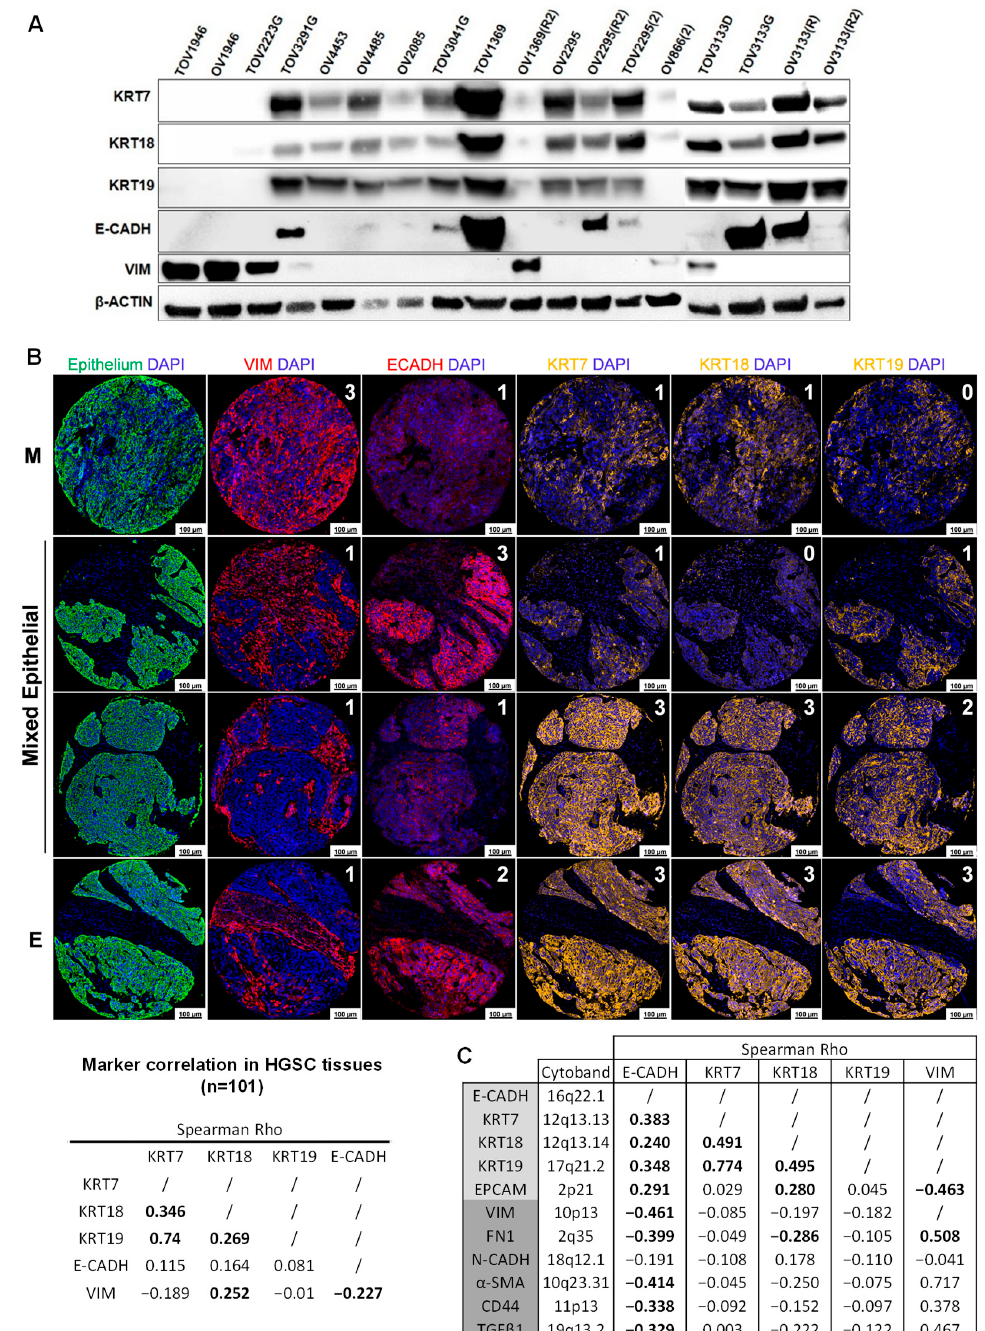
Figure 1. HGSC cell lines and tissues display a high variability in epithelial marker expression. ( A ) E-CADH, KRT7, KRT18, KRT19, and VIM protein expression was observed by Western blot in 18 HGSC cell lines. β -actin was used as normalization control. ( B ) KRT7, KRT18, KRT19, E-CADH, and VIM protein expression was observed by immunofluorescence in a TMA comprised of 101 HGSC tissues. Mean fluorescence intensity (MFI) of markers was quantified in the epithelium following digital image analysis. MFI were categorized into 4 groups of expression: 0 (negative), 1 (low), 2 (moderate), and 3 (high), using 25th, 50th and 75th percentiles, respectively, as cut-offs between groups. Spearman Rho correlations between marker expression are indicated in the table. M: Mesenchymal-like phenotype, E: Epithelial-like phenotype. ( C ) Spearman Rho correlations between KRT7, KRT18, KRT19, E-CADH, VIM, and EMT markers were obtained from protein expression measured by the CPTAC (mass spectrometry) on 274 HGSC cases extracted from TCGA (Ovarian Serous Cystadenocarcinoma dataset). Epithelial markers are highlighted in light grey and mesenchymal markers are highlighted in dark grey. Significant correlations are shown in bold ( p <